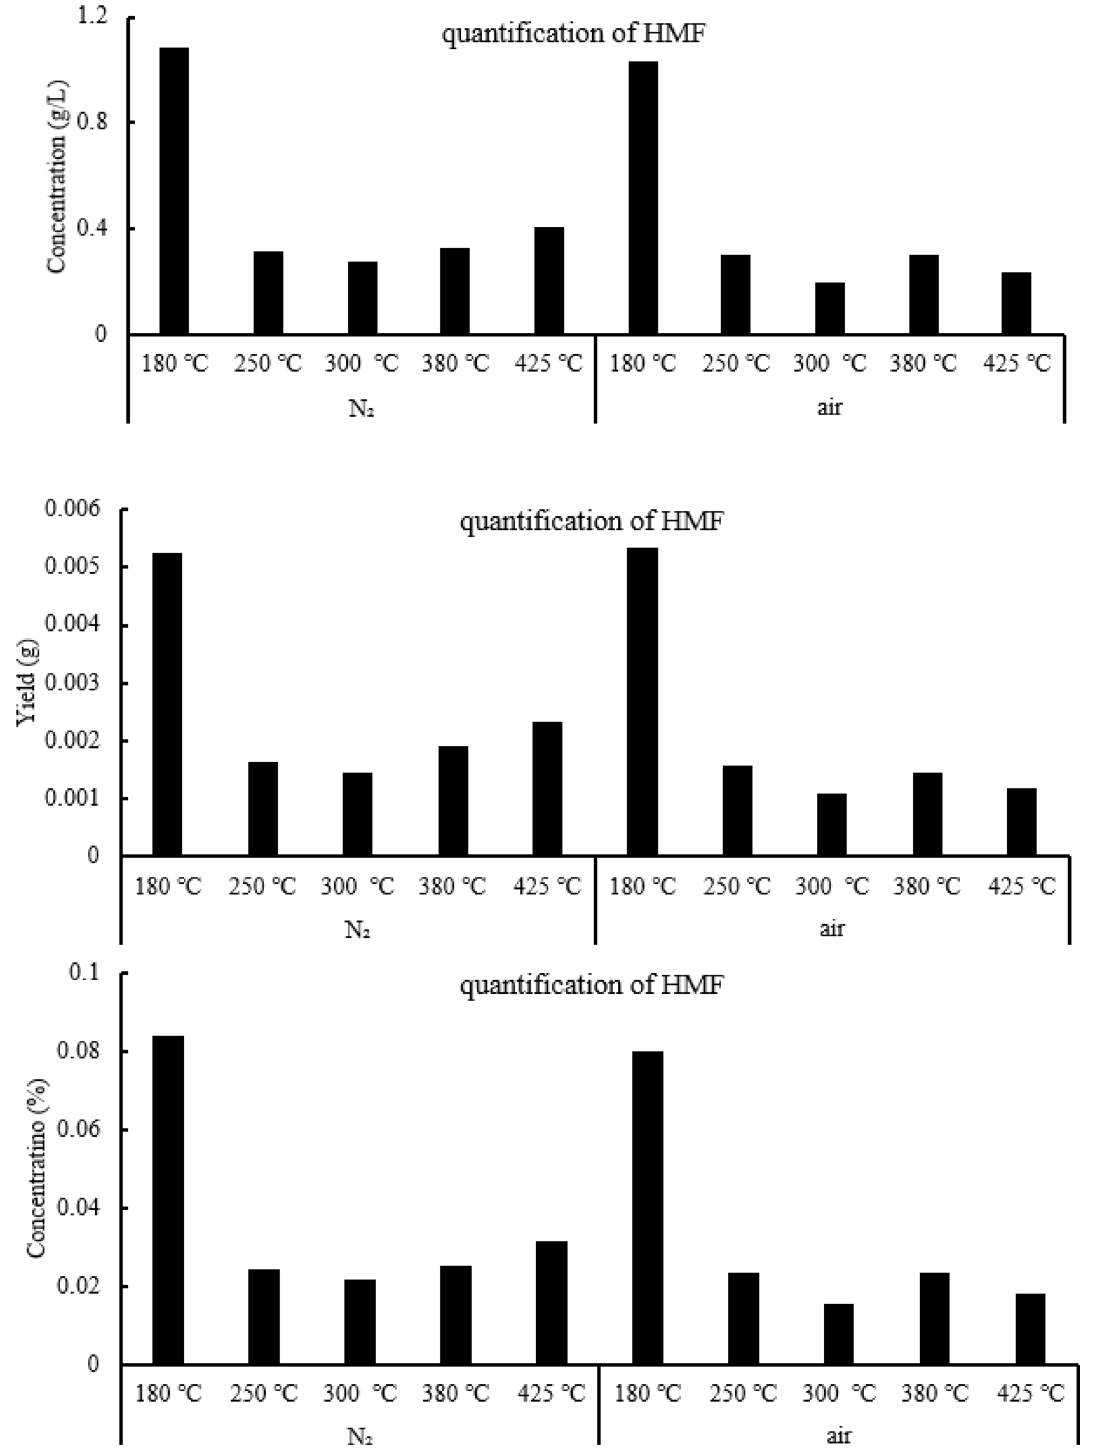
Fig. 10 Quantification of HMF by measured concentration (top; SD < 0.0419) and by yield (bottom; SD <